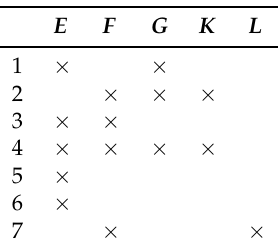
Table 4. A formal context.